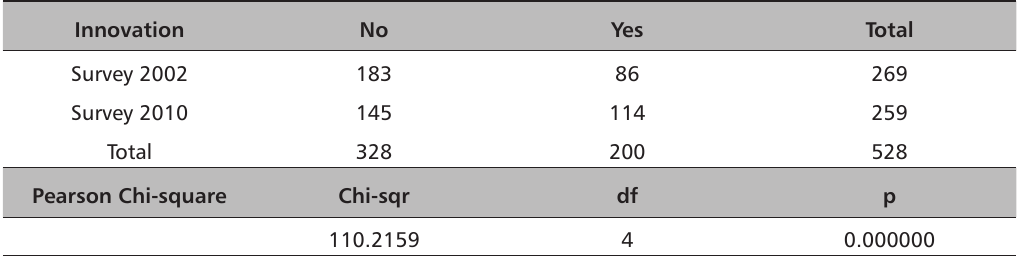
TABLE 3. Impact of time on the willingness to